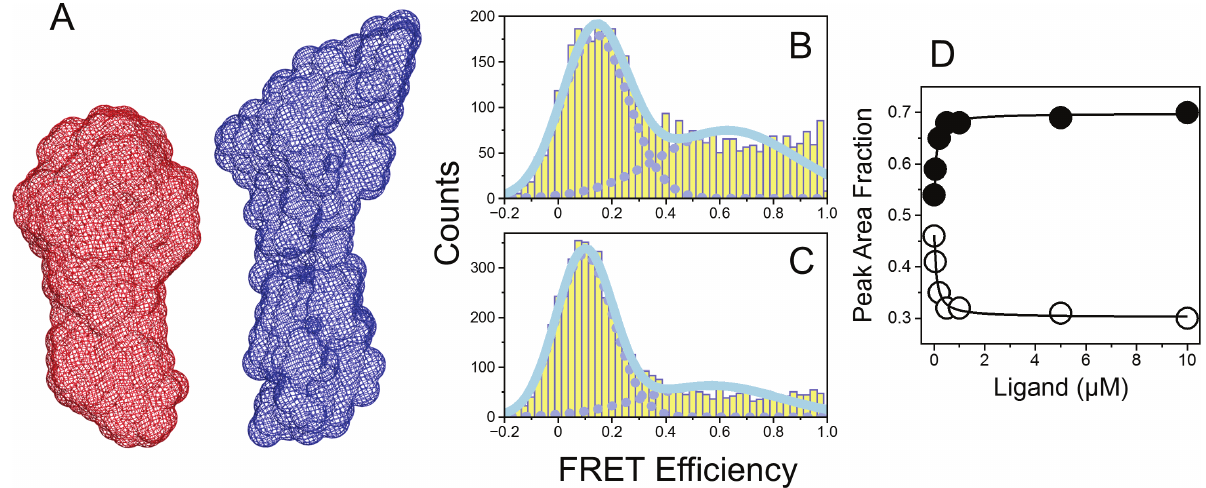
Figure 1A-D . Solution structures of prothrombin and Mz revealed by SAXS and smFRET measurements. (A) Reconstructed 3D envelopes of prothrombin (red) and Mz (blue) calculated from their respective scattering profiles. The maximal particle sizes (D Mz calculated from the pair distance distribution functions (not shown) are 120 Å and 160 Å, respectively. FRET efficiency histogram of Mz S525A labeled with the AF555/AF647 fluorophores at positions S120C/S478C measured in the absence (B) or presence(C) of saturating concentrations of H-D-Phe-Pro-Arg-p-nitroanilide (FPR). (D) Fractions of Mz molecules populating either the open (closed circles) or closed (open circles) conformations calculated at different concentrations of FPR. The K fitting the data into a single site model was 90±10